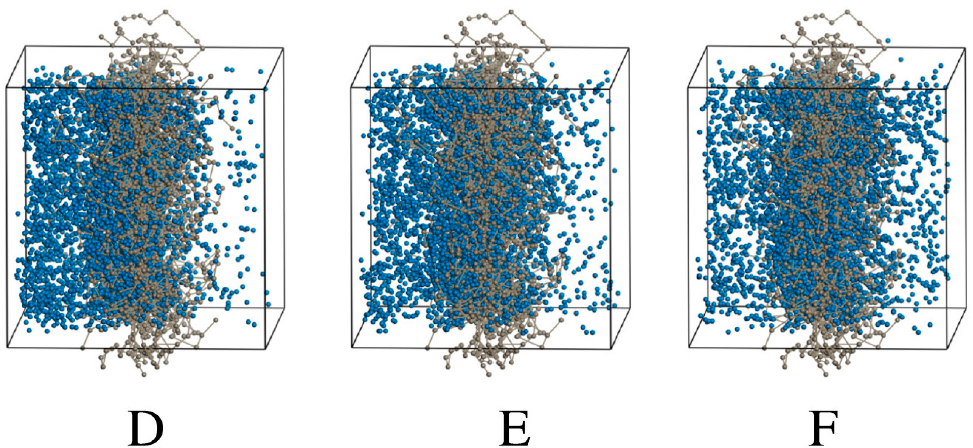
Figure 2. ( A ), the total simulation box containing neutral salicylic acid only with wall beads (purple), nitrocellulose (grey), salicylic acid (blue), water (green) and propylene glycol (yellow). Only nitrocellulose and salicylic acid beads are shown at different times as multiples of τ during the trajectory simulation; ( B ) 1 τ , ( C ) 75,000 τ , ( D ) 250,000 τ , ( E ) 500,000 τ , ( F ) 1,000,000 τ . Pharmaceuticals 2018 , 11 , x FOR PEER REVIEW